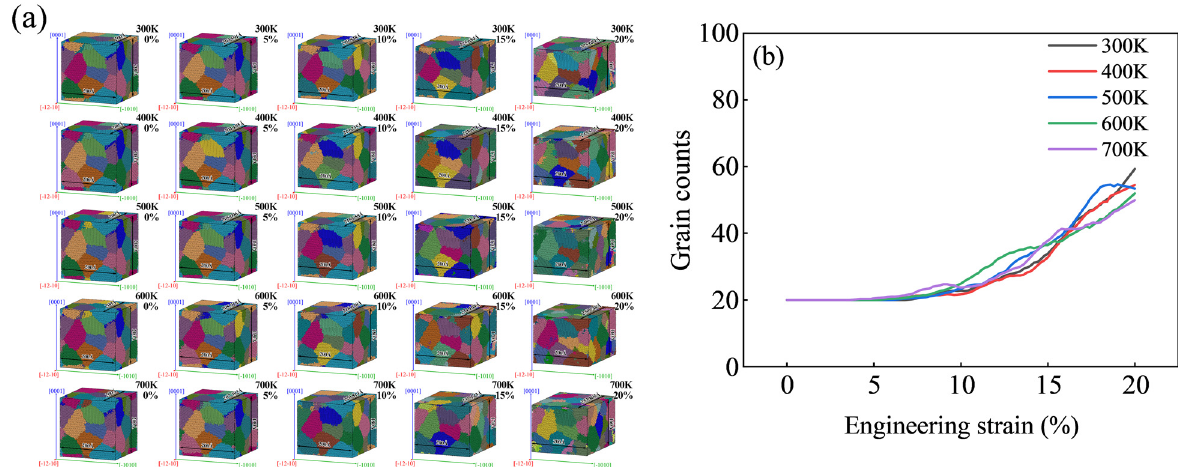
Figure 10: Grain evolution: ( a ) grain diagram and ( b ) grain number curve.